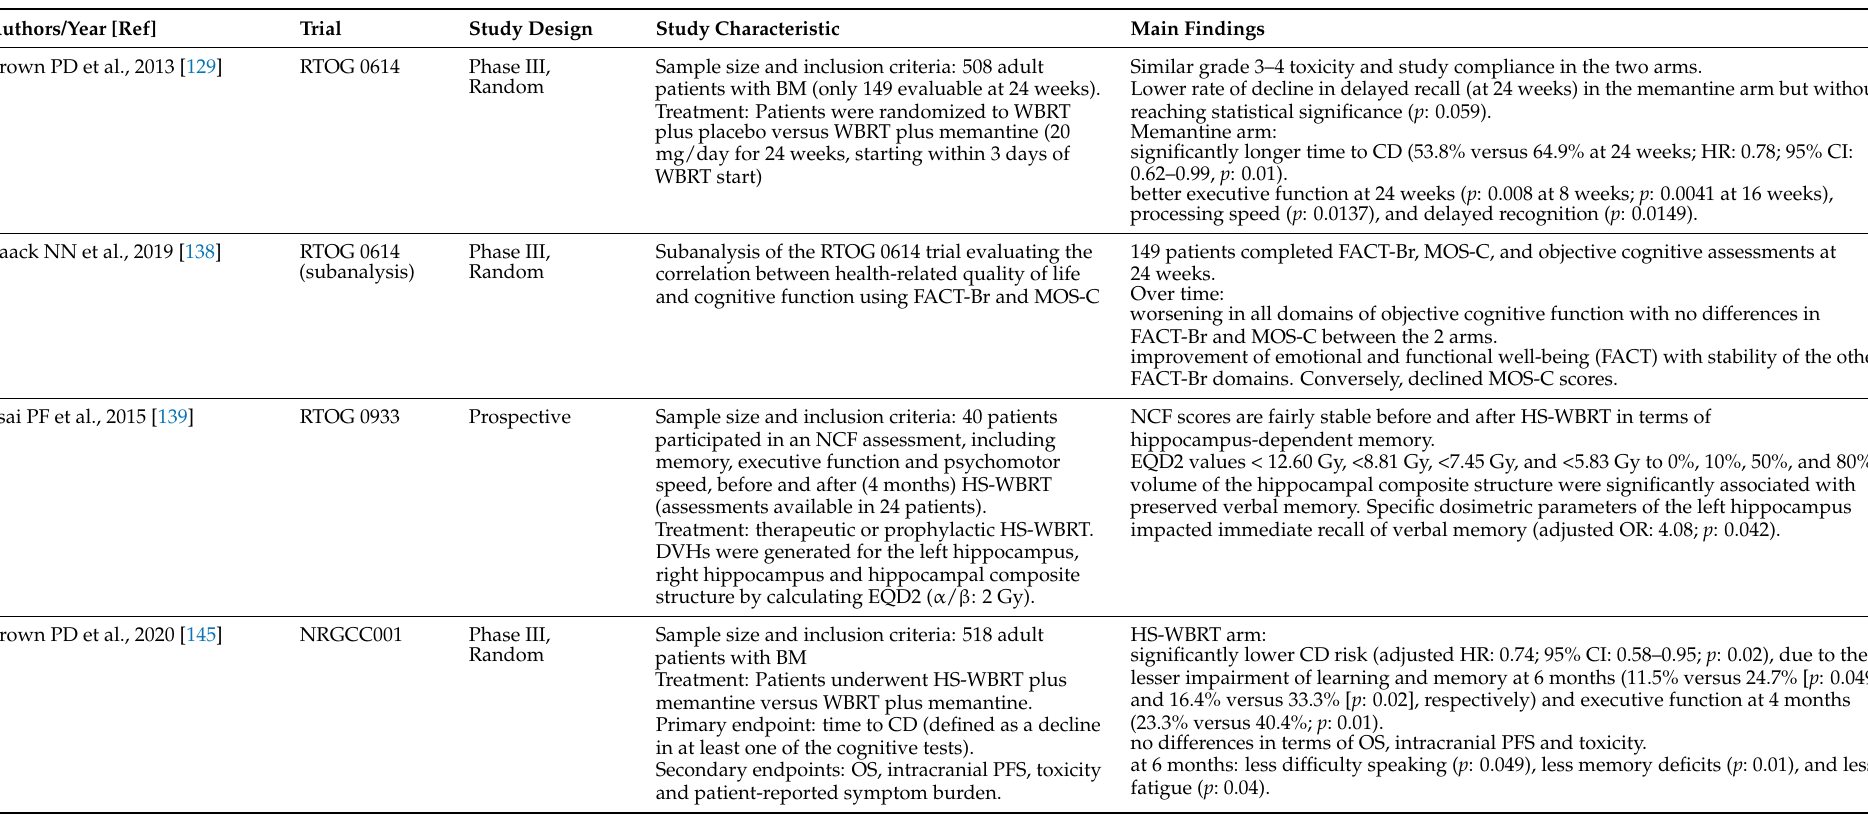
Table 1. Results of the main trials on memantine combined with whole-brain radiotherapy and hippocampal-sparing whole-brain